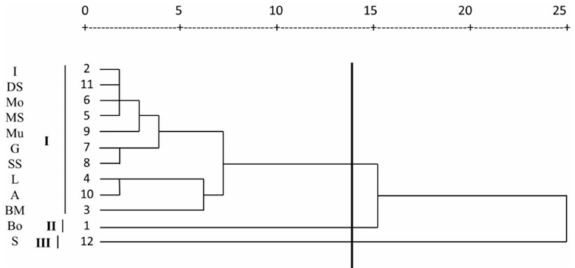
Figure 3. Dendrogram of the Matricaria chamomilla populations resulting from the cluster analysis (based on Euclidean distances) of the volatile oil components. chemotype I ( α -bisabolone oxide A and α -bisabolol oxide A), chemotype II (chamazulene and α -bisabolol oxide B), chemotype III (( Z ) and ( E )- γ -bisabolene).